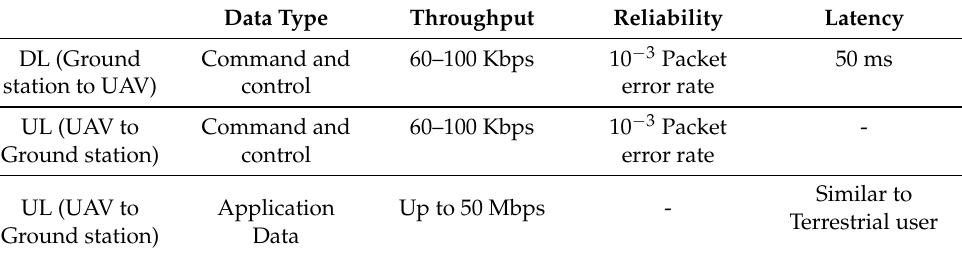
Table 1. Air-to-ground communication requirements for drone operations specified by 3GPP